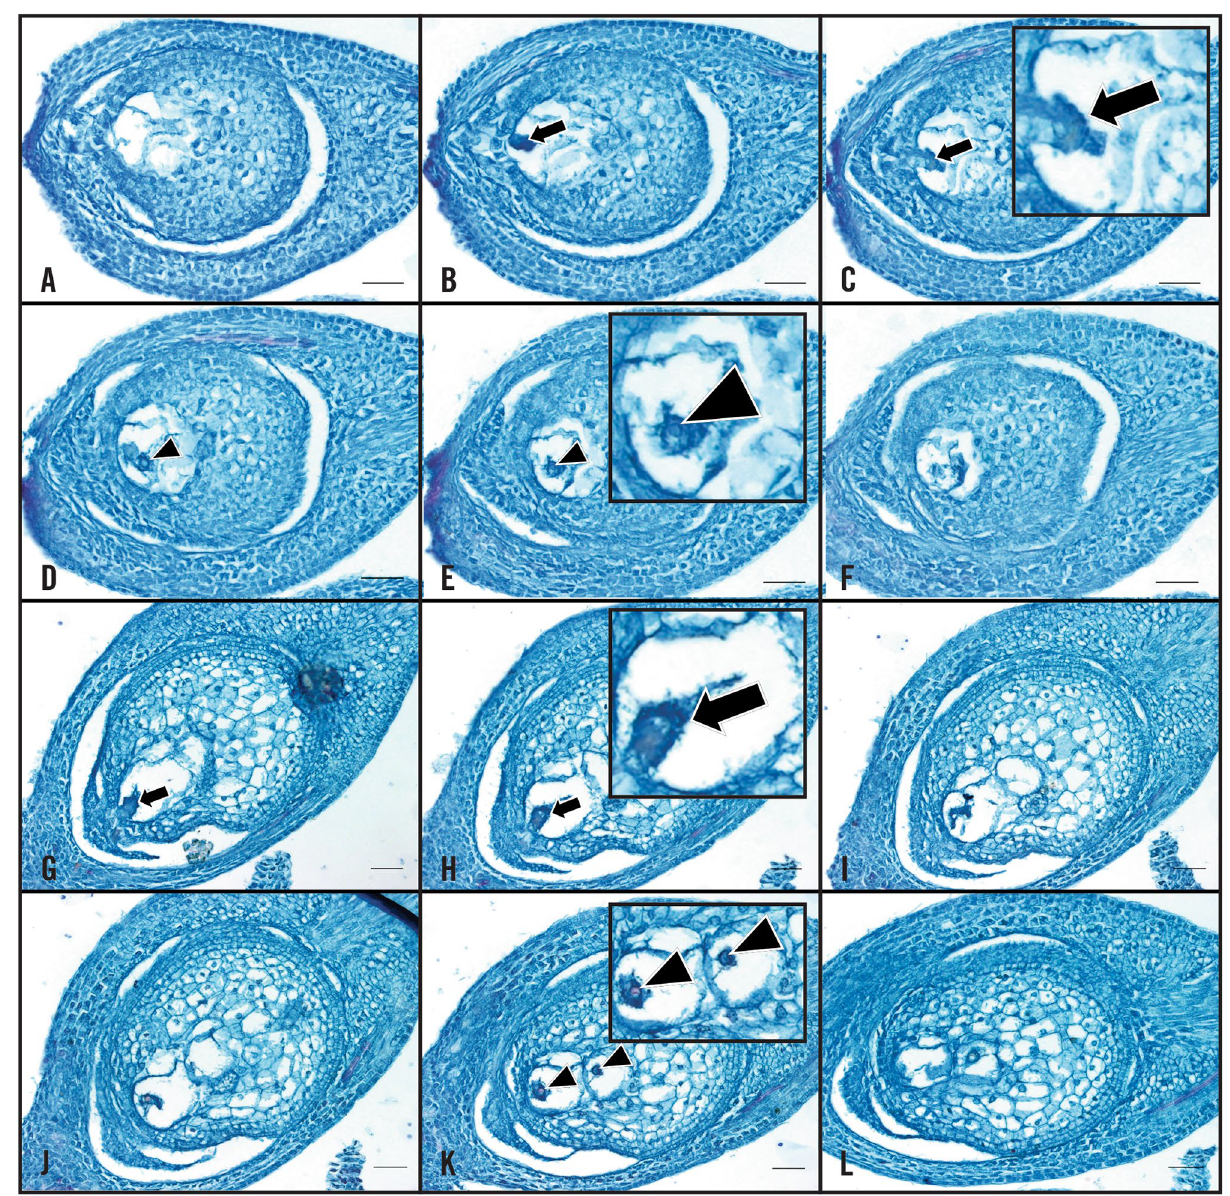
Figure 1. Buffelgrass ovary sections stained with Safranin & FastGreen. ( A – F ) Serial sections of sexual genotype B-2s showing a single sexual embryo sac. ( G – L ) Serial sections of aposporous genotype B-12–9 showing multiple aposporous embryo sacs. Egg cells are indicated by arrows and polar nuclei are indicated by triangles, scale bar = 50 μm. Enlarged insets have been provided for some